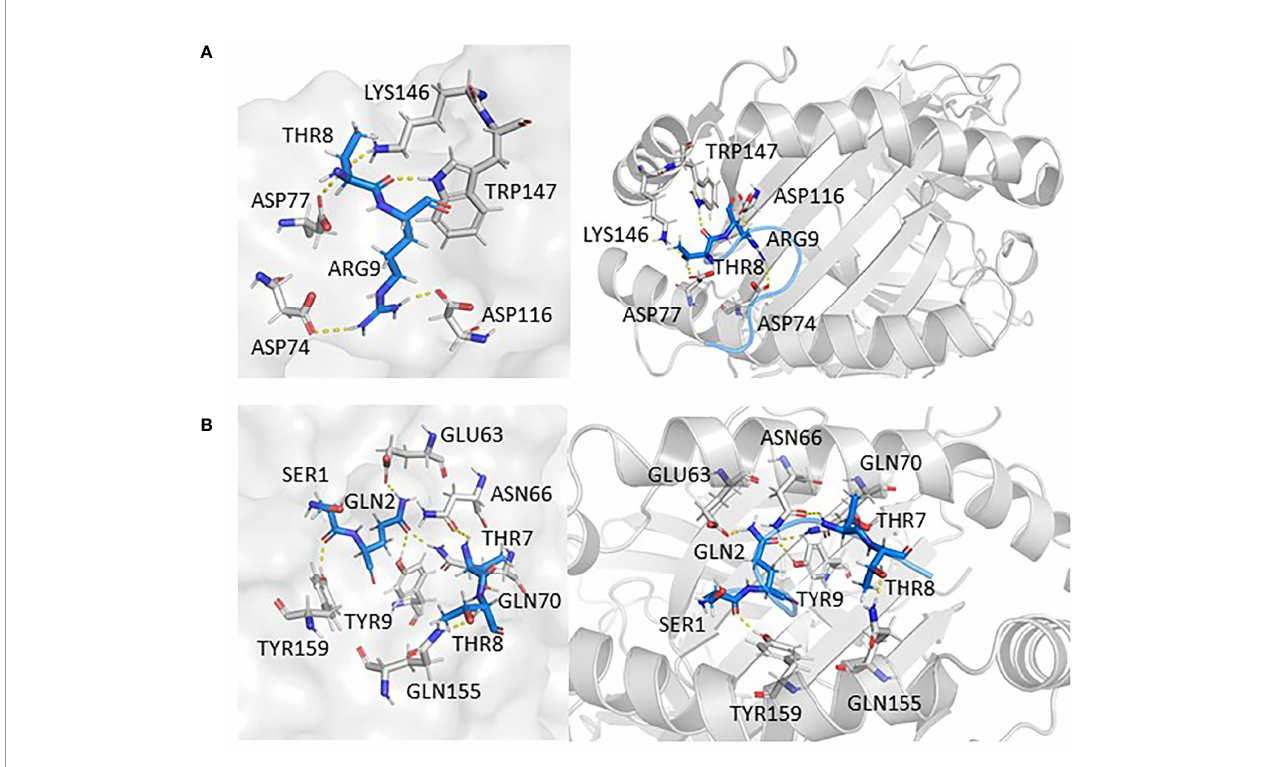
FIGURE 5 | The interaction between epitopes obtained from L18F and HLA-A*11:01. Here, epitopes are shown in marine, HLA structure is shown in gray. (A) HLA-A*11:01(1Q94)-SQCVNLTTR (WT). (B) HLA-A*11:01(1Q94)-SQCVNFTTR (MT). RMSD, root mean square deviation; MT, mutation type; WT, wild